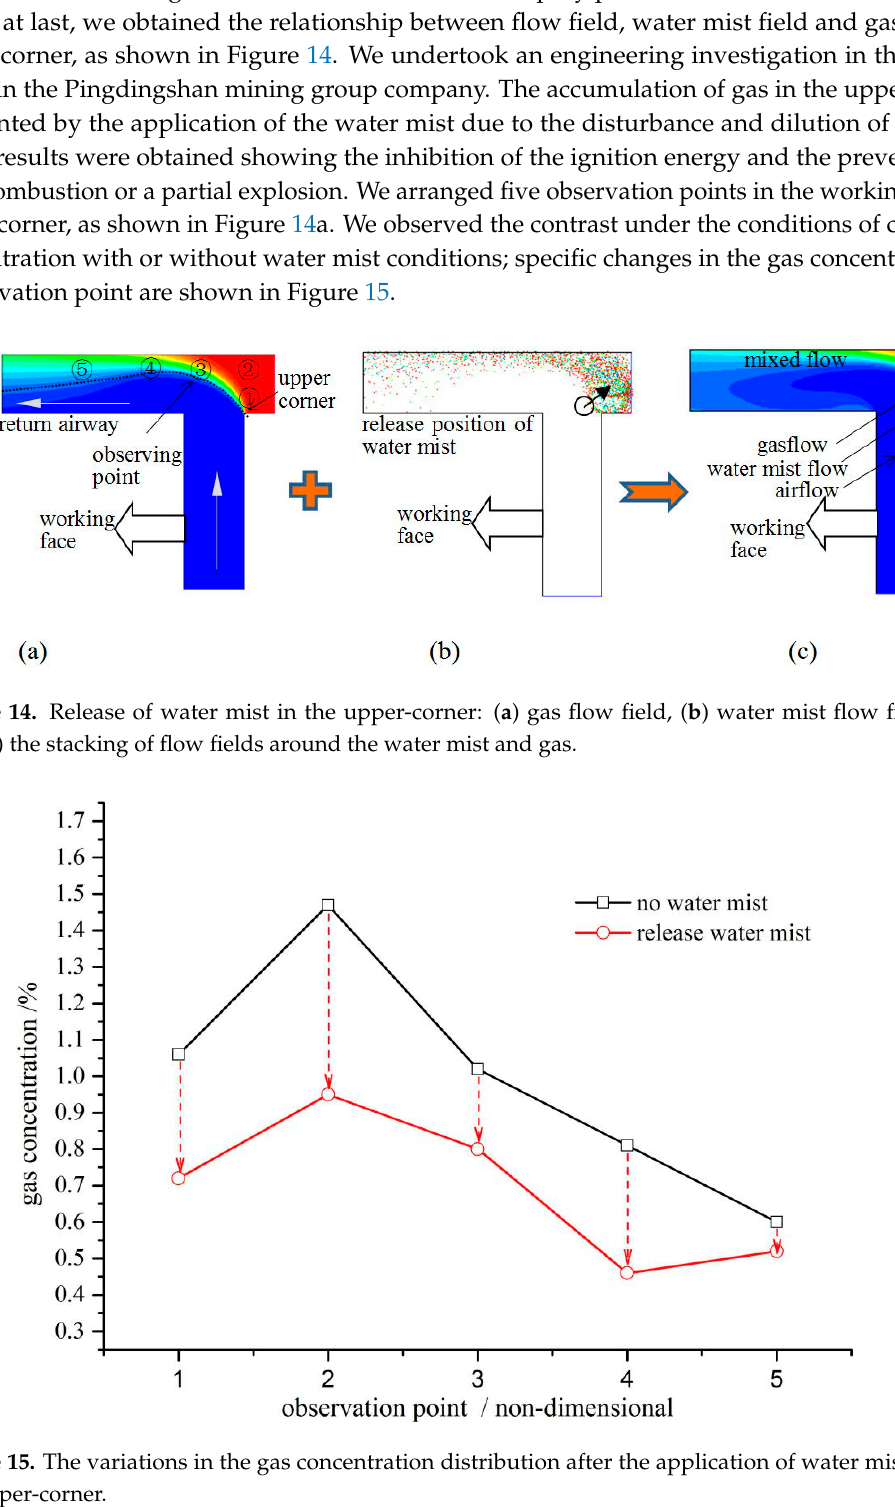
Figure 13. Upper-corner gas combustion and explosion suppression system: 1 closed water tank, 2 backup pump, 3 main pump, 4 shut-off valve, 5 pressure relief valve, 6 additives, 7 mixed filter, 8 manometers, 9 hand control valve, 10 automatic starting valves, 11 Nozzle, and 12 gas detection probe.